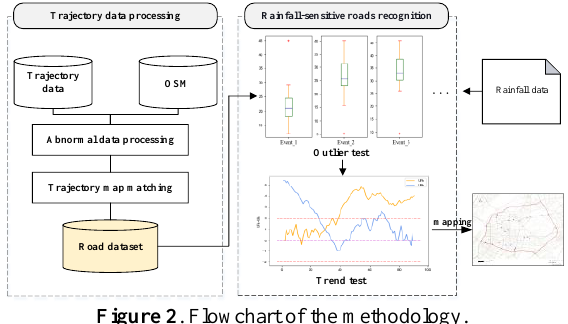
Figure 2 . Flowchart of the